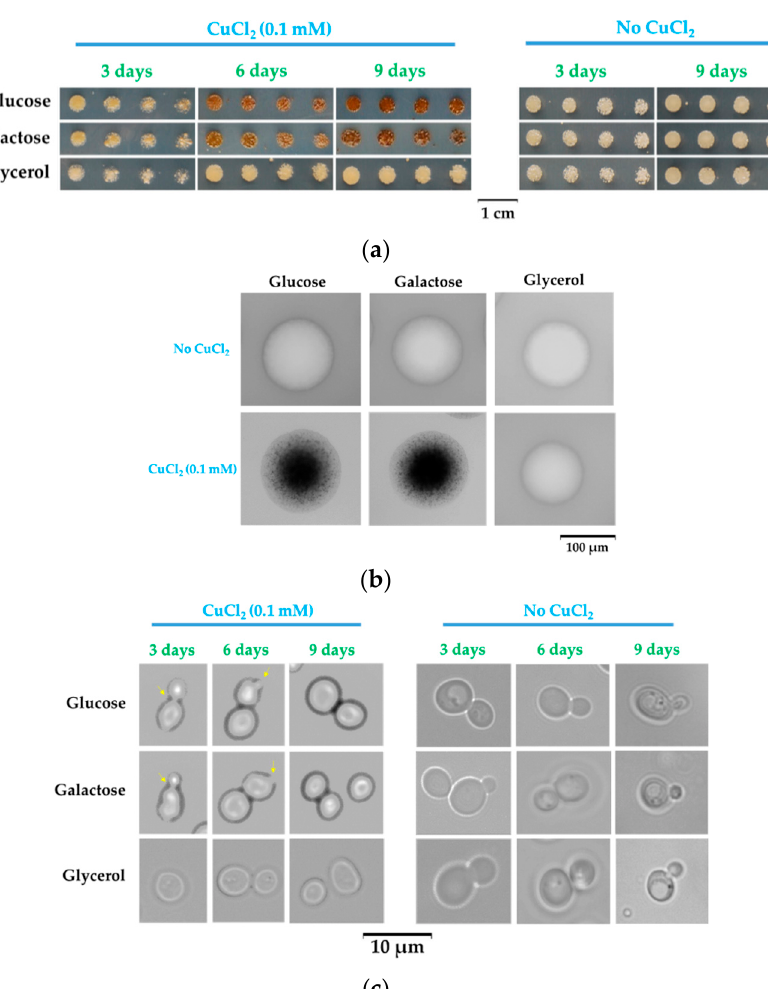
Figure 1. Coloration of Saccharomyces cerevisiae grown on copper-containing medium. ( a ) Cell suspensions of strain BY4741 were spotted in serial dilution on minimal defined media (MM)/Glc (Glucose), MM/Gal (Galactose), or MM/Gly (Glycerol) media with or without additional CuCl 2 . Plates were observed daily and photographed at various times. ( b ) Microscopic images of yeast colonies grown from one single cell for 9 days on MM with or without 0.1 mM CuCl 2 . ( c ) Microscopic images of yeast cells grown on media enriched with 0.1 mM CuCl 2 . Cells were picked from duplicate plates shown in ( a ). Grey images are shown, for clarity, in ( b , c ).